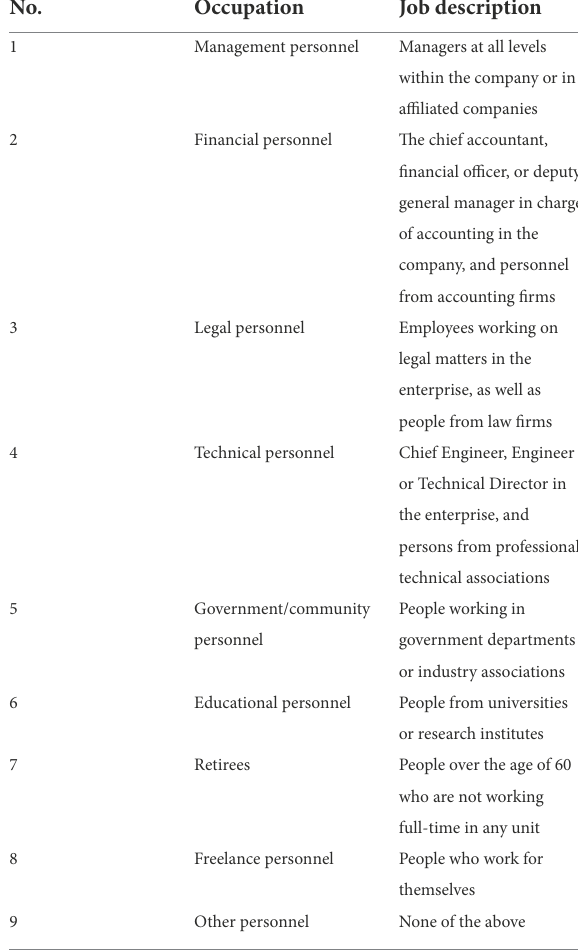
TABLE 2 Classification of board members’ functional background. TABLE 3 Classification of board members’ occupational